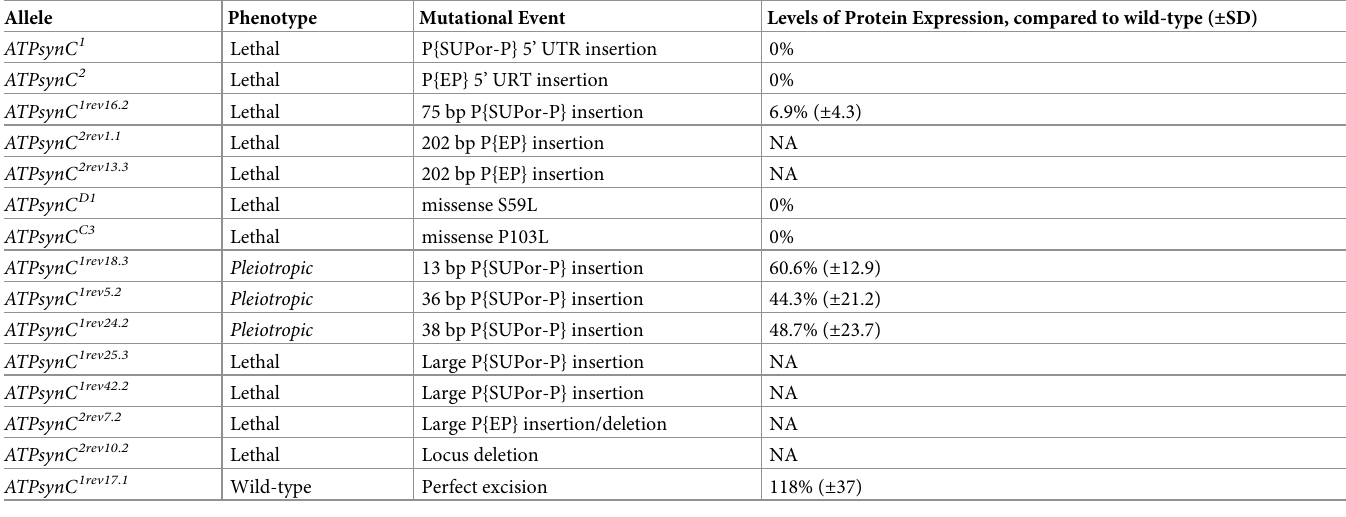
Table 1. ATPsynC alleles and